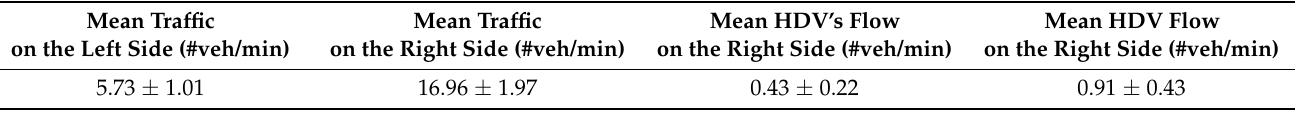
Table 1. Traffic flow (#vehicle/minute) on each side of Dominion road based on observation made in 2019. Mean Traffic on the Left Side